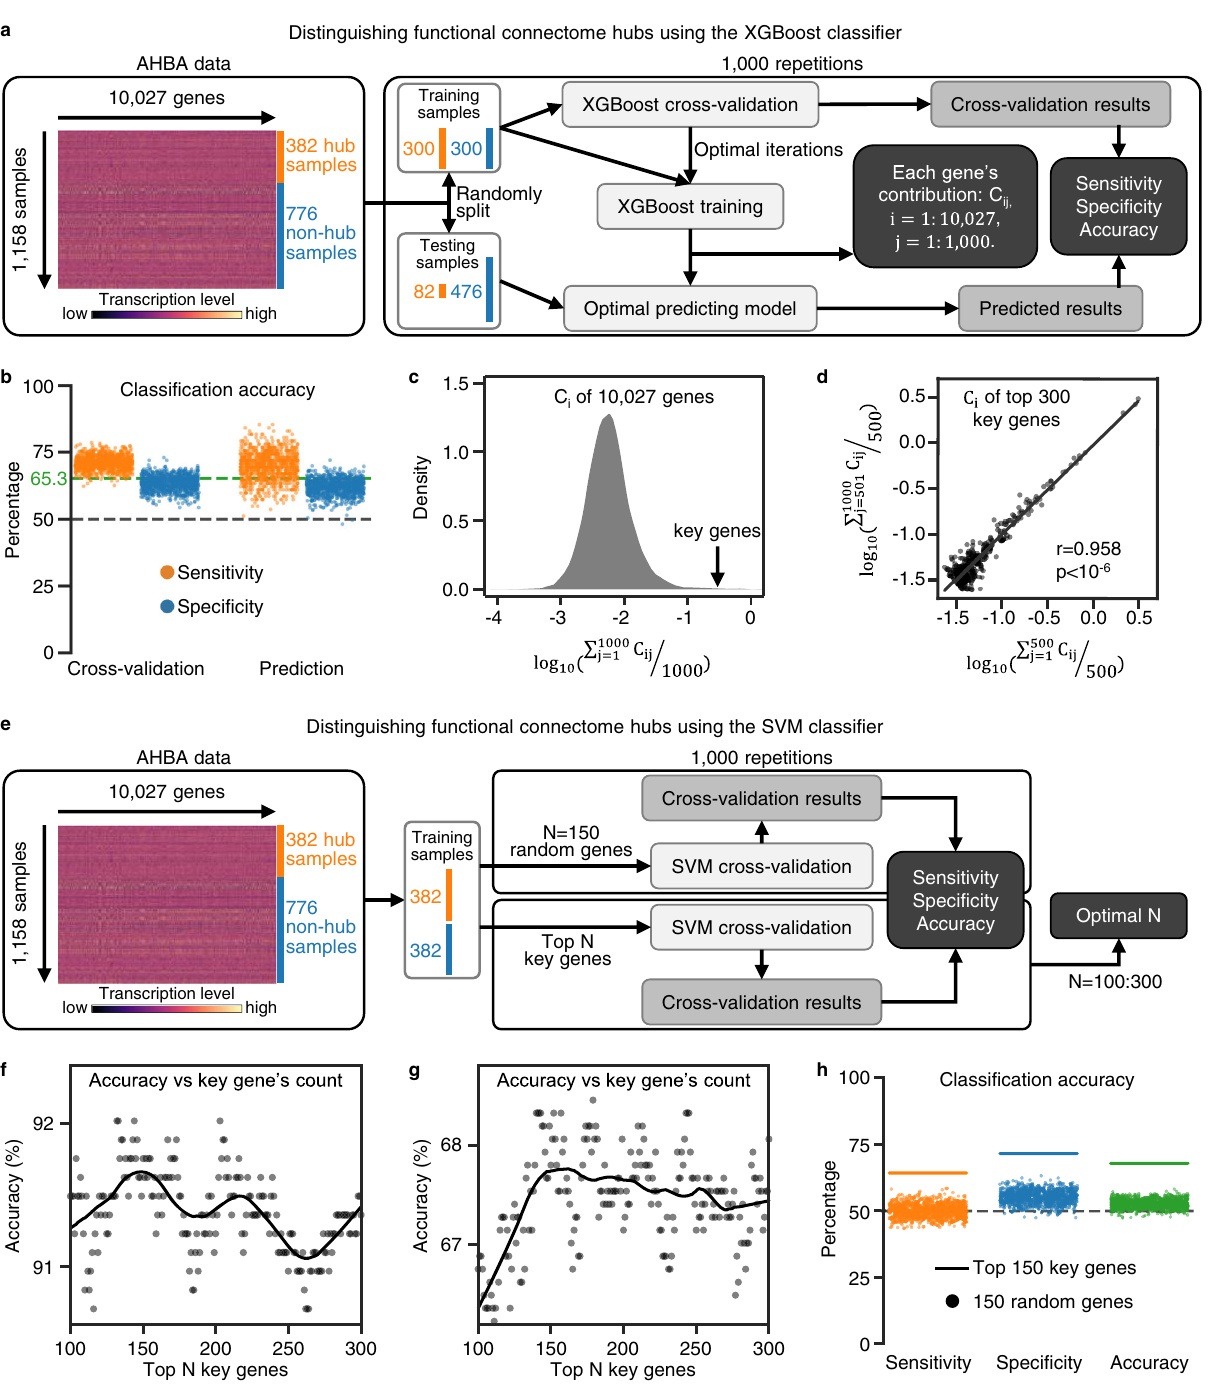
Fig. 5 Transcriptomic data distinguishes connectome hubs from non-hubs. a Schematic diagram of using the XGBoost model to classify brain samples as a hub or non-hub. b Performance of the XGBoost classi fi er. Each dot represents one repetition in a . The horizontal gray dashed line represents the chance level accuracy rate (50%). The horizontal green dashed line represents the average accuracy rate (65.3%) of the XGBoost classi fi er across 1000 repetitions. c Density plot of 10,027 genes ’ logarithmic average contributions across 1000 repetitions to the XGBoost classi fi er. Genes with the greatest contributions were regarded as key genes. d Regression plot of the logarithmic average contributions of the top 300 key genes across the fi rst 500 repetitions versus those across the second 500 repetitions. Each dot represents one gene. e Schematic diagram of using the SVM model to classify brain samples as a hub or non-hub. f , g Accuracy rate of the SVM classi fi er versus the count of key genes used to distinguish 382 hub samples from 382 non-hub samples with the highest rate ( f ) or lowest rate ( g ) to be correctly classi fi ed by the XGBoost classi fi er. Each dot represents one SVM classi fi er. Black curves were estimated by locally weighted regression. h Performance of the SVM classi fi er. Horizontal lines correspond to the SVM classi fi er trained using top 150 key genes in g . Each dot represents one repetition using 150 randomly selected genes in e . The horizontal gray dashed line represents the chance level accuracy rate